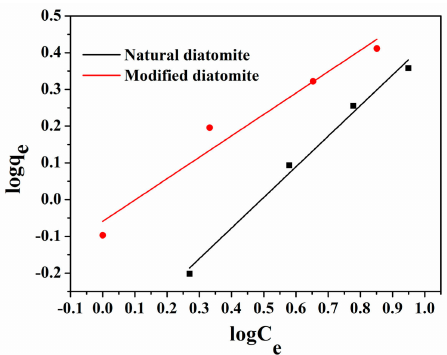
Figure 9. Diatomite adsorption 1-naphthol of Freundlich isotherm plots. Black: raw diatomite; Red: calcined 450 ◦ C diatomite.